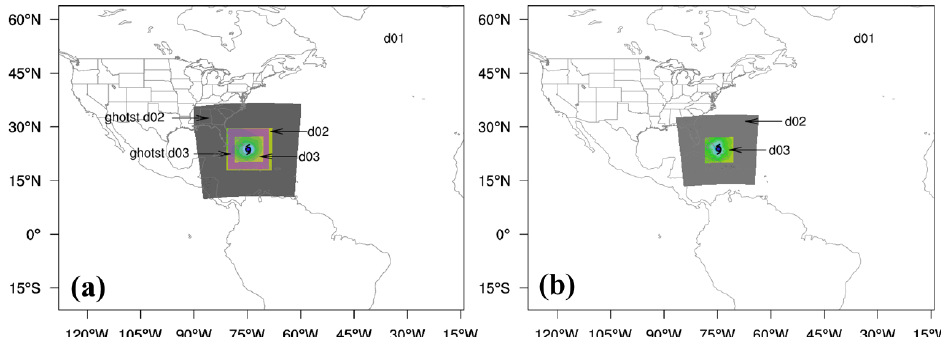
Figure 2. ( a ) Forecast domains, as indicated by d01, d02, and d03, and HWRF data assimilation domains, as indicated by ghost d02 (black shaded area), and ghost d03 (pink shaded area) for the 3DEnVar initialization framework; and ( b ) forecast domains and data assimilation domains as indicated by d01, d02 and d03 for 4DEnVar initialization framework. Data assimilation in the 4DEnVar initialization framework is directly performed on d02 and d03. The black symbol indicates the storm center from National Hurricane Center (NHC) best track (black storm sign).